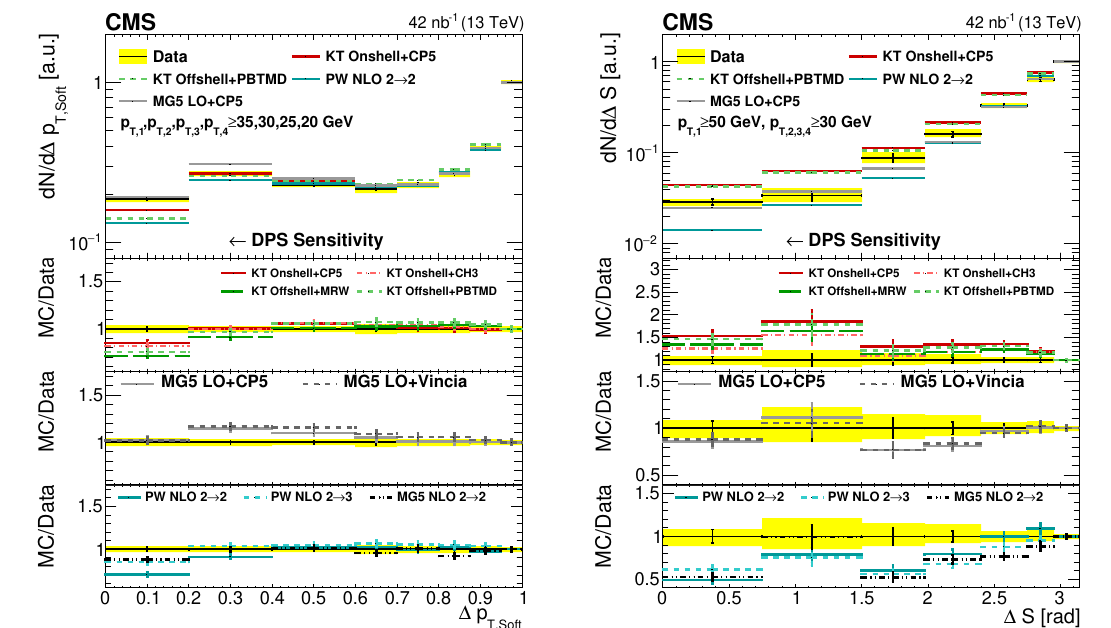
and ∆ S distributions from data to different KaTie (KT), Figure 9 . Comparison of the ∆ p T,Soft MadGraph 5_a mc@nlo (MG5), and powheg (PW) implementations in Region I and Region II, respectively. All distributions have been normalized to regions where a reduced DPS sensitivity is expected. The error bars represent the statistical uncertainty, and the yellow band indicates the total (statistical+systematic) uncertainty on the measurement.